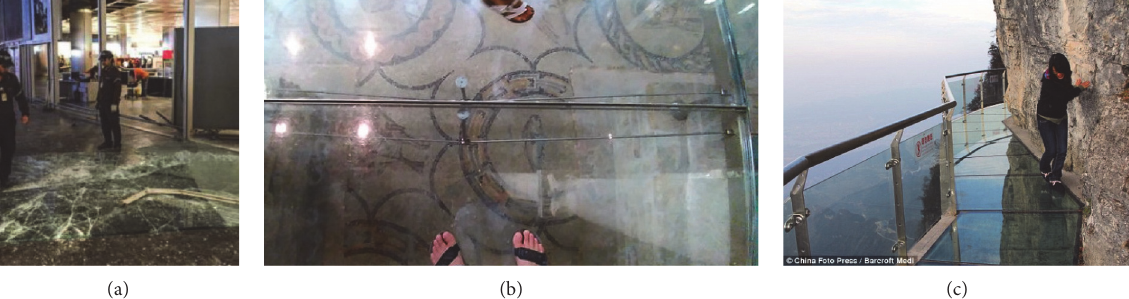
Figure 1: Selection of glass built scenarios: (a) cracks and shards in glass walls and windows under hazard (reproduced from [24] with permission from Elsevier ® , copyright license agreement n. 5042381253637, April 2021); (b) indoor pedestrian system (walkway in Aquileia, IT; reproduced from [9] under the terms and conditions of CC-BY license); (c) Cliffside skyway, CN (reproduced from [25] under the terms and conditions of CC-BY